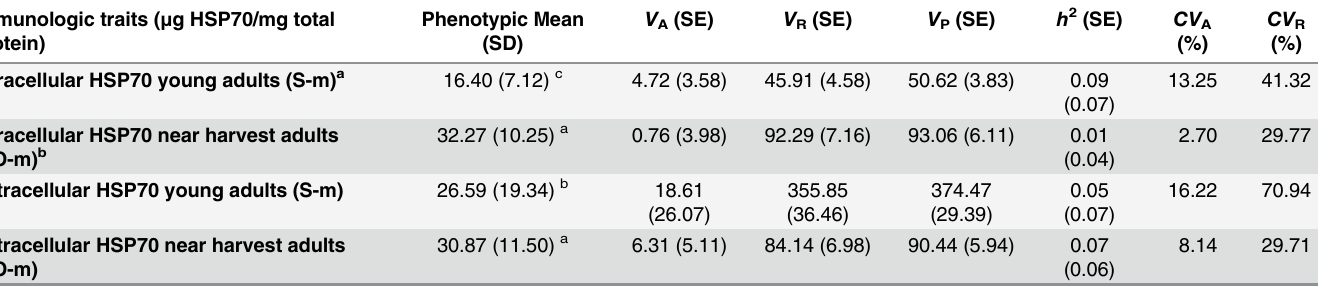
Genetic estimates of the additive genetic variance ( V A ); residual variance ( V R ); phenotypic variance ( V P ); heritability ( h 2 ); and coef fi cients of additive genetic variance ( CV A ) and residual variance ( CV R ).